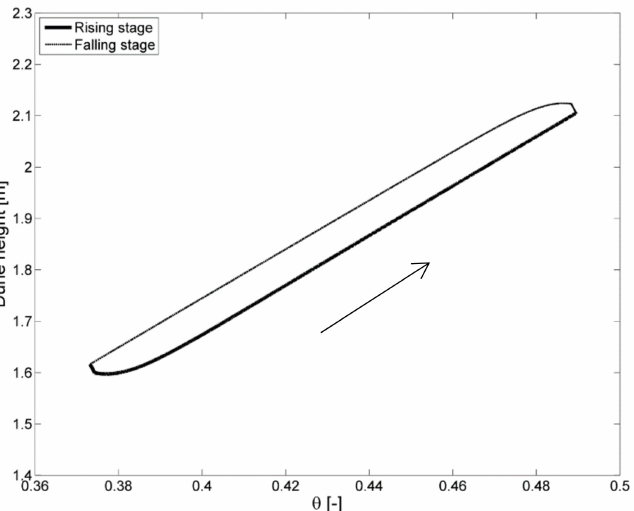
Figure 14. Non-dimensional shear stress θ versus dune height for the rising and falling stages of the hydrograph, using the river scenario. The arrow signifies the direction of development over time.